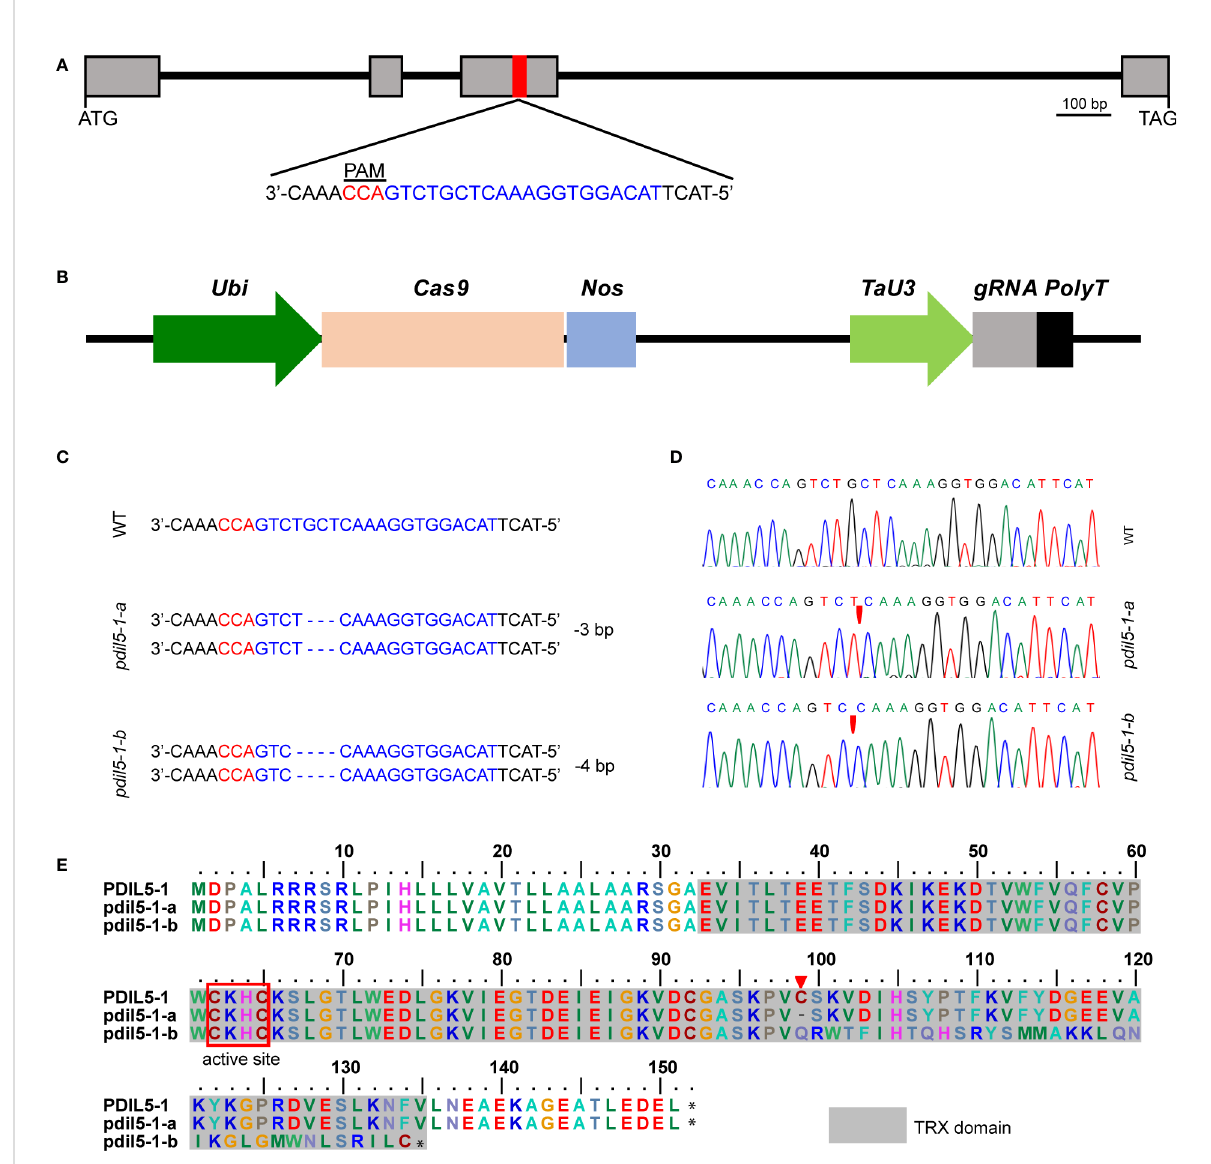
FIGURE 1 CRISPR/Cas9-induced targeted mutagenesis of HvPDIL5-1 in barley. (A) Gene structure of HvPDIL5-1 and sequence of the target site. The target site for sgRNA within the third exon of HvPDIL5-1 is highlighted in red. The protospacer-adjacent motif (PAM) and target sequence are highlighted in red and blue, respectively. Exons and introns are shown as gray boxes and black lines, respectively. (B) Schematic representation of the linearized CRISPR/Cas9 vector. Ubi , Zea mays Ubiquitin promoter; Nos , Nos terminator; TaU3 , sgRNA promoter; PolyT , a 7-bp poly(T) sequence. (C) Changes in the HvPDIL5-1 nucleotide sequence in the two mutants. The sgRNA and PAM sequences are highlighted in blue and red, respectively. WT: wild-type sequence. ‘ - ’ , deletion of the respective nucleotide. (D) Sanger sequencing chromatograms of the target region in wild type ‘ Golden Promise ’ and the two mutants. Red triangles represent the mutations. (E) Amino acid sequence alignment of PDIL5-1 in the wild type and mutants. The TRX (thioredoxin-like) domain and active center are indicated by gray and red boxes, respectively. The red triangle indicates the amino acid